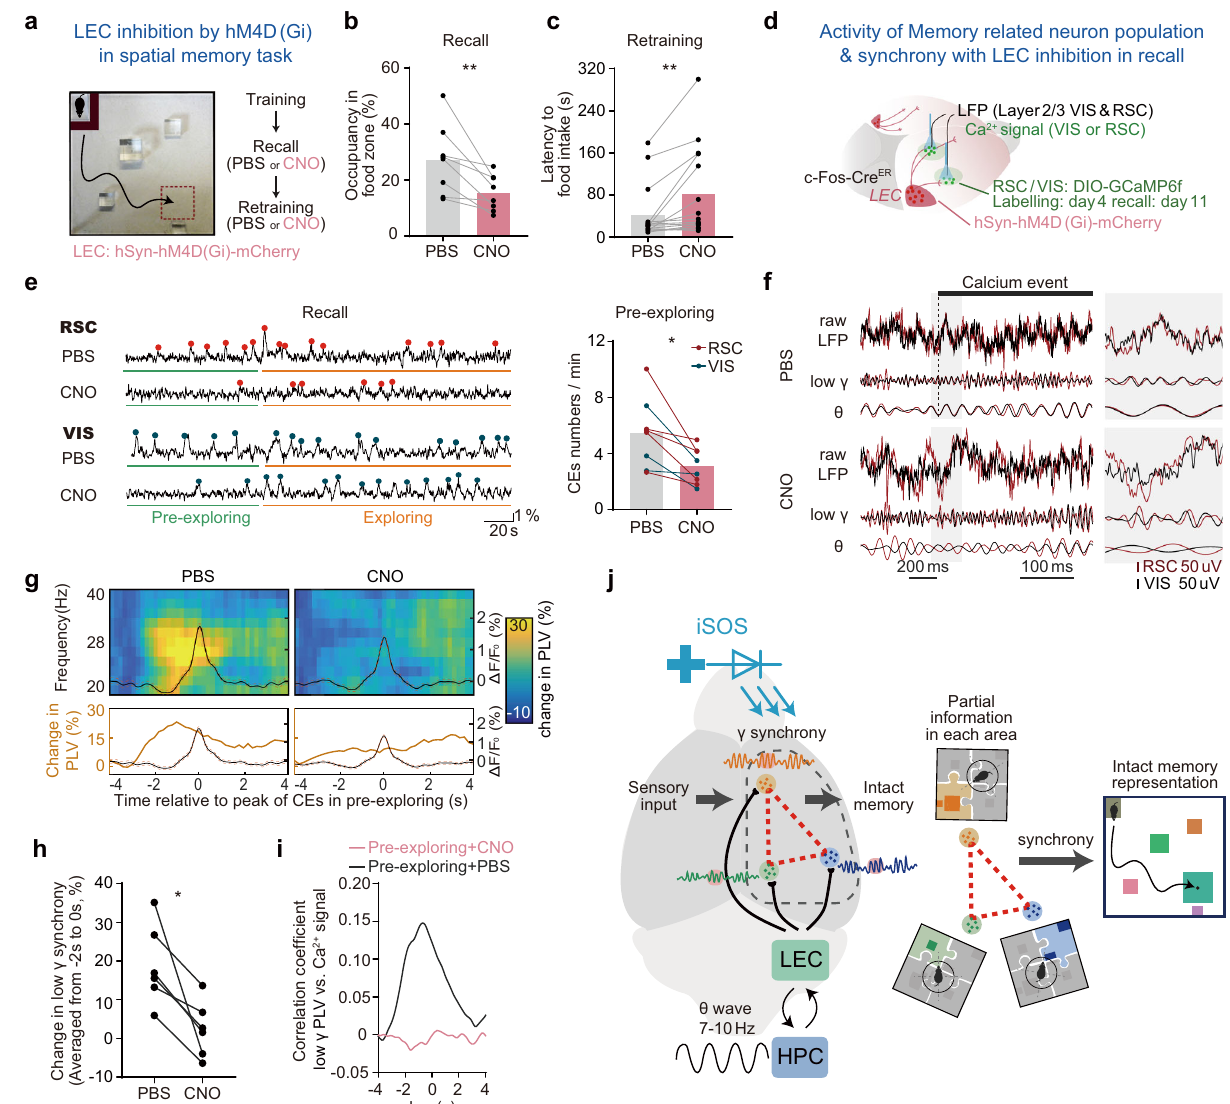
Fig. 6 LEC-mediated long-range gamma synchrony is essential for cortical memory-related neurons reactivation and memory retrieval in HPC-intact mice. a Experimental scheme for LEC inhibition by hM4D(Gi) in spatial memory recall and retraining to test if LEC is essential for successful memory recall. b – c Inhibition of LEC activity impair memory recall. b Occupancy in the food zone signi fi cantly decreased in recall trail ( N = 15 mice, two-sided paired t -test, t (14) = 3.5, P = 0.0036). c Latency to the reward in the following retraining trail increased ( N = 15 mice, two-sided paired t -test, t (14) = 3.2, P = 0.0067), CNO dosage: 2 mg/kg. d Similar to Fig. 5a, experimental scheme shows calcium signals from labeled neurons (labeled in training day4) and LFPs were recorded simultaneously during memory recall with or without LEC inhibition. e Left, calcium signal examples of labeled neurons in RSC and VIS with or without LEC inhibition. Right, quanti fi cation of CEs frequency in pre-exploring phase of memory recall (N total = 8 mice with three recorded in VIS and 5 in RSC, two-sided paired t -test, t (7) = 3.5, P = 0.0105). Red and blue dots indicate the peaks of the detected RSC and VIS calcium events, respectively. f Examples of LFPs around calcium events from the pre-exploring phase of recall trials with PBS and with CNO, the black bar above LFPs indicate the time range from rising time to the peak of the calcium event, illustrating theta ( θ ) and gamma ( γ ) LFPs transiently synchronized with zero-phase lag at the rising time of the calcium event while it is not the case in CNO administration recall trial. g Averaged synchrony (RSC-VIS) spectrogram, spectrograms were aligned to each peak of RSC or VIS calcium events in the pre-exploring phase during memory recall with or without LEC inhibition. (N PBS = 90 CEs, N CNO = 75 CEs, from six animals). h Change in low gamma synchrony in panel g (averaged PLV from − 2s to 0 s) was quanti fi ed for each mouse. LEC inhibition impaired the coupling between engram activity and cortical low gamma synchronization (N total = 6 mice, paired two-sided t -test, t (5) = 3.541, P = 0.0165). i Cross-correlation analysis. Averaged correlation coef fi cient between low gamma synchrony and RSC or VIS engram activity in pre-exploring phase with CNO administration (red, N = 6 mice) or not (black, N = 6 mice). * P < 0.05. j Model for the mechanism in which long-range cortical gamma synchrony mediates memory encoding and retrieval by HPC/LEC. The illustration shows that the cortical long-range gamma synchrony is coupled to the theta wave and engram activities. Such a process might underlie hippocampus-mediated memory encoding and recall in the neocortex in a highly coordinated way. Engram coding partial context information in each cortical region was integrated by gamma synchronization and this integration contribute to intact memory